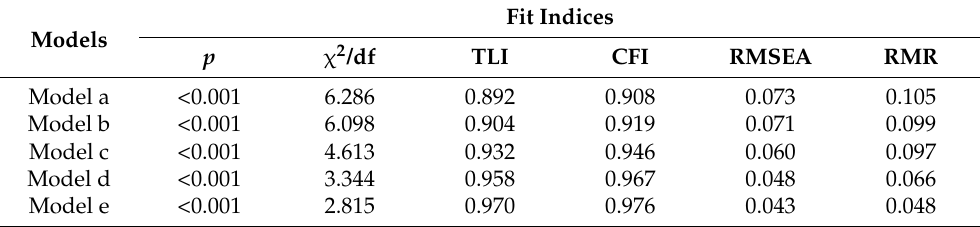
Table 3. Fit measures for the IES-2